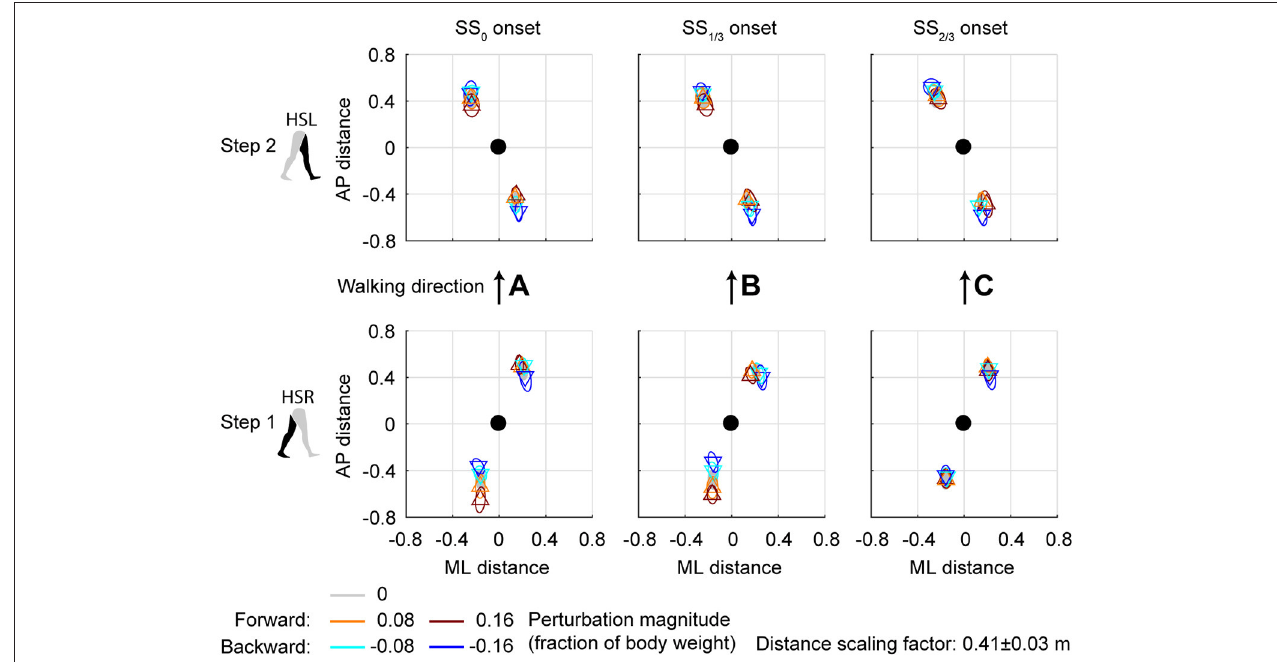
FIGURE 7 | Foot locations following AP perturbations. (A) Top-down view of the locations of the COM of the leading and trailing foot relative to the whole body COM at (0,0). Perturbation onset was at SS 0 . Bottom plot corresponds to the first step (HSR), top plot corresponds to the second step (HSL) after the perturbation. (B) Same as (A) , but for perturbation onset at SS 1 / 3 . (C) Same as (A) , but for perturbation onset at SS 2 / 3 . Triangles show subject-averages and correspond to the perturbation direction. Ellipses represent the subject-standard deviation. Colors indicate the different perturbation magnitudes. Data is shown